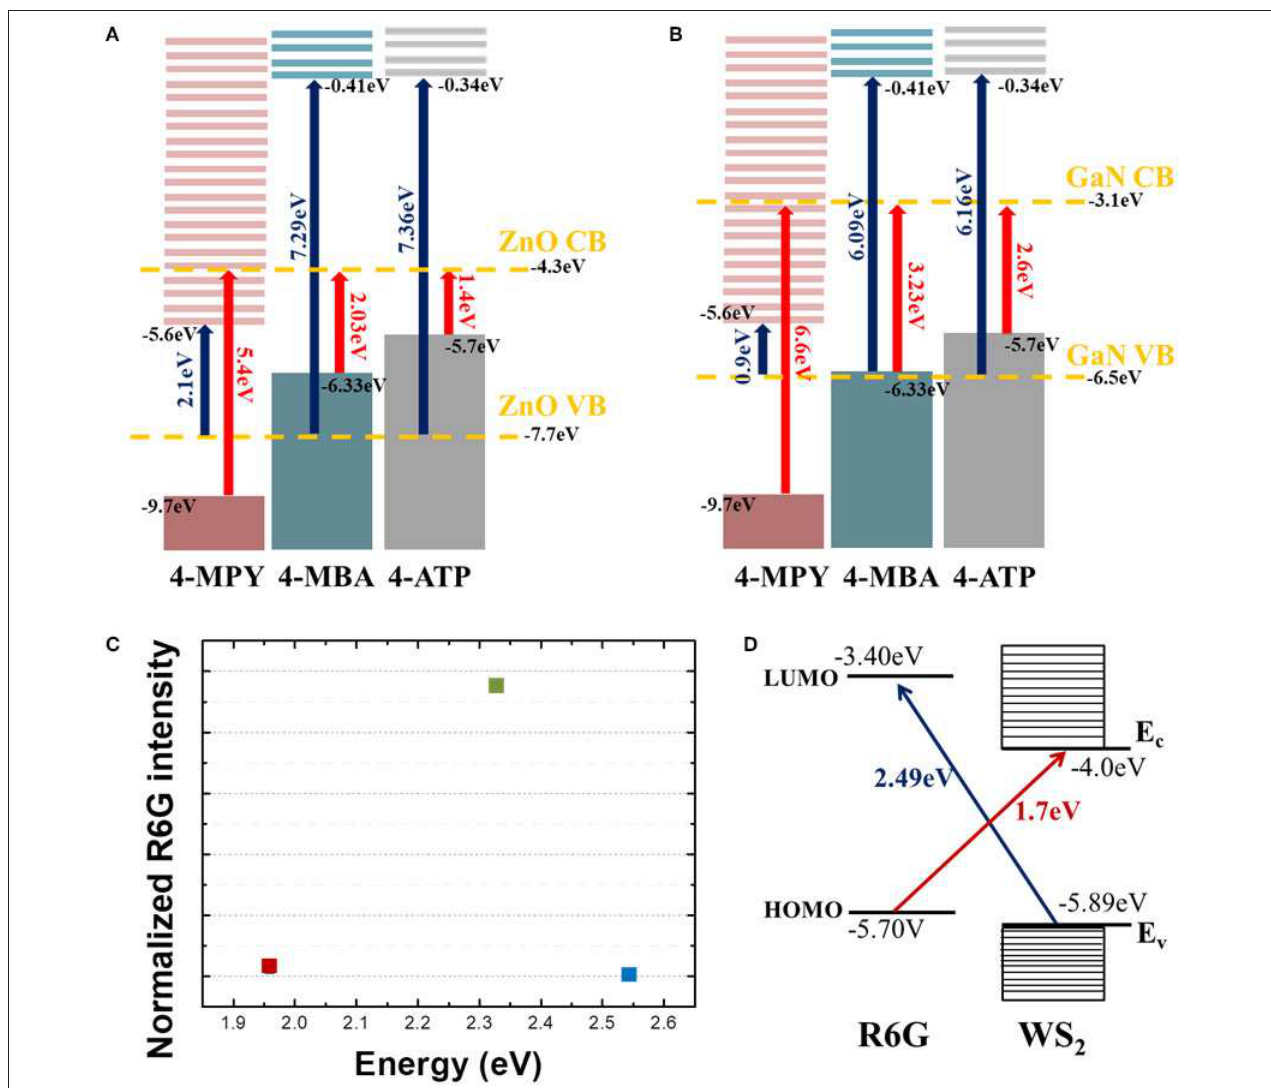
FIGURE 4 | Energy level diagrams of three molecules (4-MPY, 4-MBA, 4-ATP) with (A) ZnO and (B) GaN. Bands of each semiconductor are denoted by yellow dashed lines. All vertical arrows indicate possible charge transfer routes between molecules and semiconductor substrates. Blue arrows denote charge transfer transition from semiconductor valence band (VB) to LUMO of molecules, and red arrows denote charge transfer transition from HOMO of molecules to semiconductor conduction band (CB). (C) Normalized (to Si phonon intensity) intensity of R6G 1368 cm − 1 mode with three different excitation laser wavelengths. (D) Energy level schematics of R6G and WS 2 . The red arrow denotes a charge transfer route from HOMO of R6G to WS 2 CB, and the blue arrow denotes a charge transfer route from WS 2 VB to LUMO of